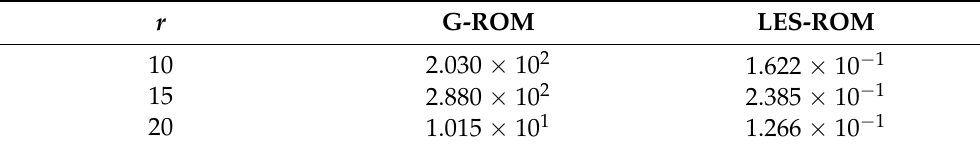
Figure 12. Under-resolved, predictive regime. Time-averaged streamfunction, ψ , for FOM, G-ROM, and LES-ROM with r = 10. Table 5. Under-resolved, predictive regime. Relative L 2 errors (36) of the time-averaged streamfunc- tion for G-ROM and LES-ROM for different r values.